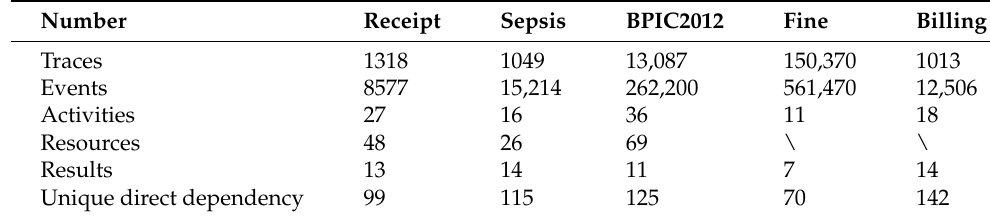
Table 1. Statistical information of